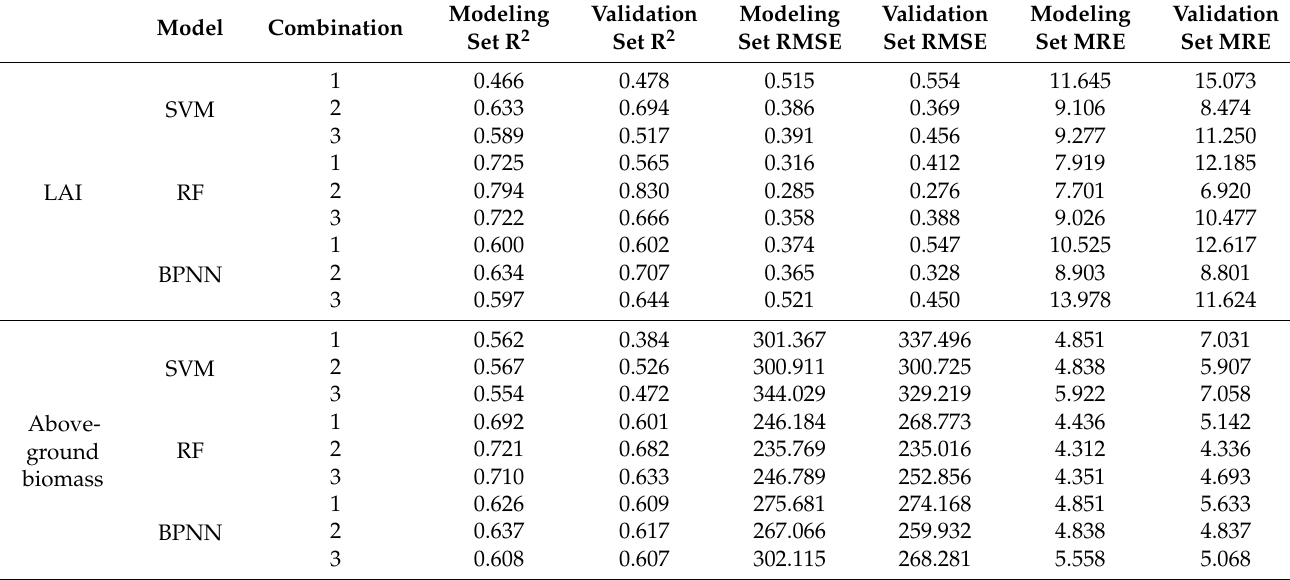
Table 5. Comparison of precision test results of estimation